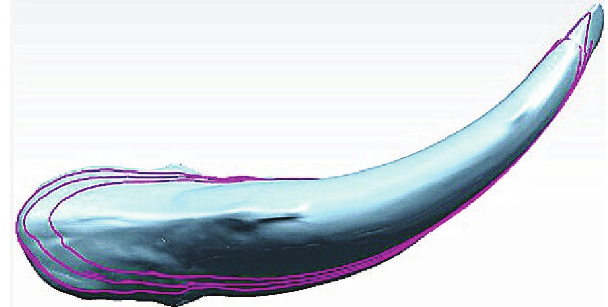
Figure 5: Rebuilding of tiger shark model.